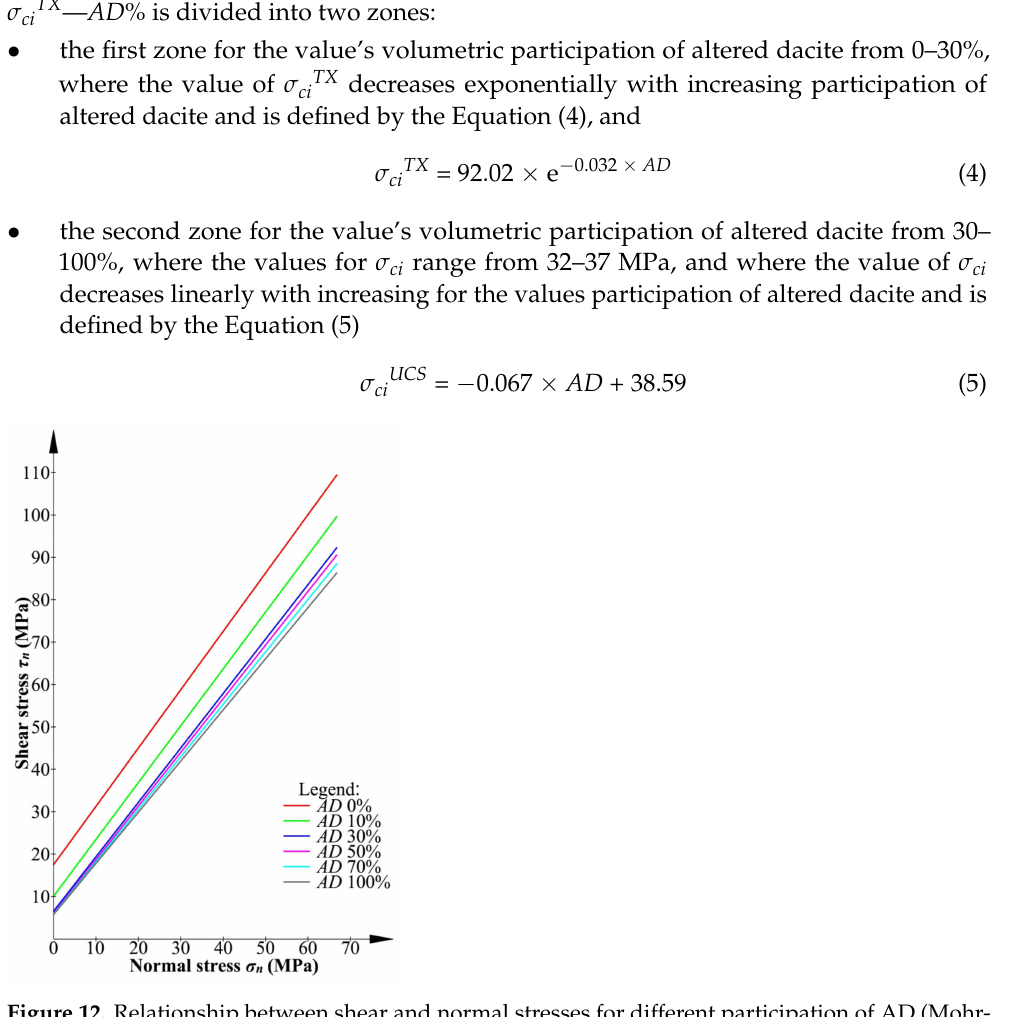
Figure 12. Relationship between shear and normal stresses for different participation of AD (Mohr- Coulomb failure criterion).